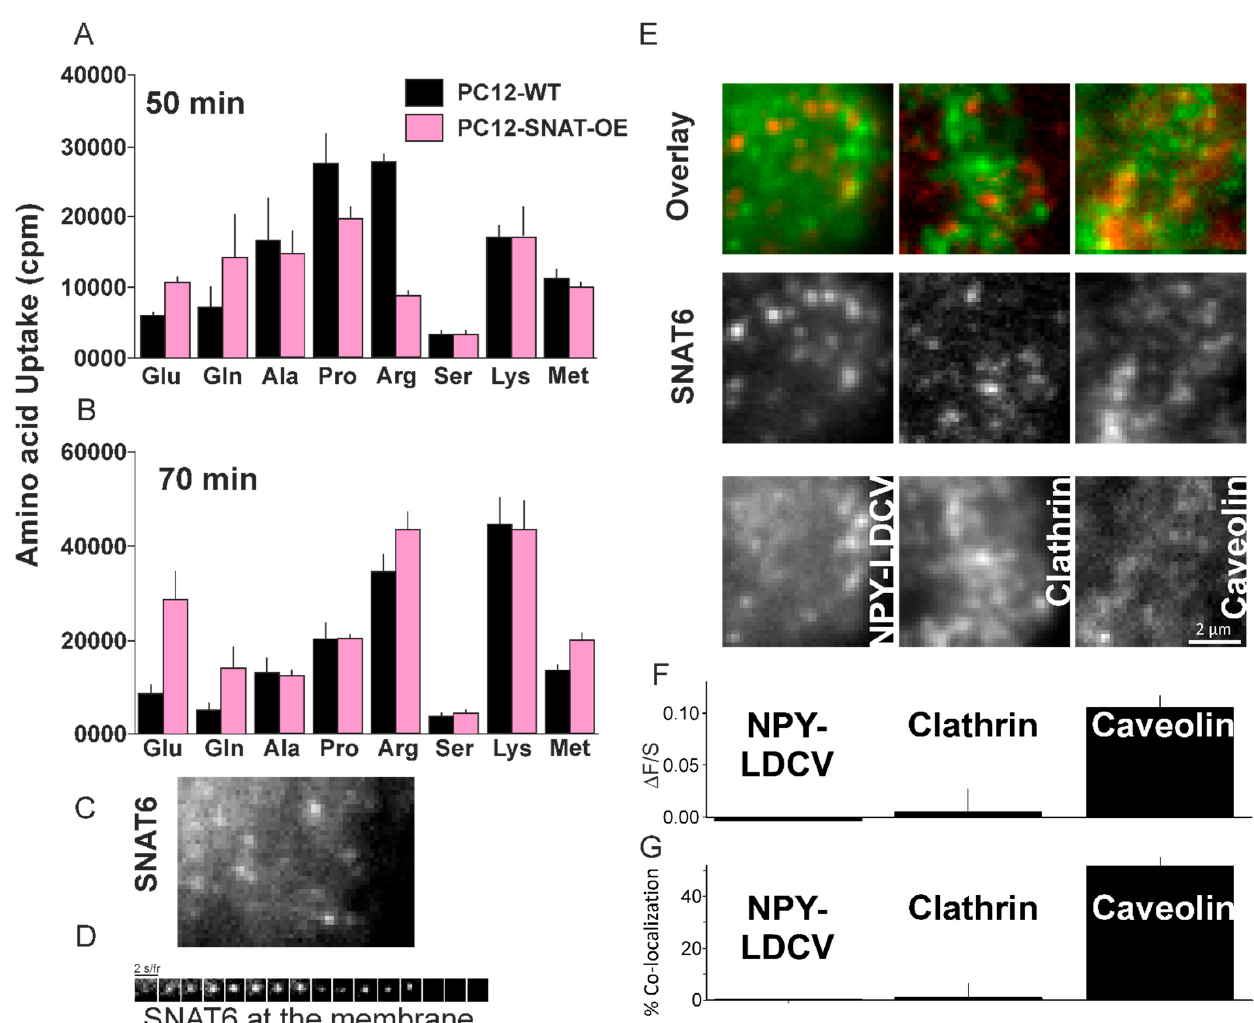
Figure 4. Role of SNAT6 in amino acid uptake and internalization. ( A ) Uptake in counts per minute (cpm) for 50 minutes by wildtype PC12 cells and PC12 cells overexpressing SNAT6 are plotted. ( B ) Uptake in counts per minute (cpm) for 70 minutes by wildtype PC12 cells and PC12 cells overexpressing SNAT6 are plotted. 3H-labeled Glutamine, glutamate, alanine, proline, arginine, serine, lysine and methionine are used for both time points. All measurements were performed in duplicates for multiple times and mean value is shown. Significantly higher uptake ( p < 0.001) is shown for the amino acids - glutamine and glutamate in PC12-SNAT6-OE cells compared to PC12-wt cells after 50 mins. ( C ) A TIRF microscopy image showing cells overexpressing SNAT6-EGFP at the plasma membrane ( D ) Time series strip showing disappearance of SNAT6-EGFP from the plasma membrane in presence of glutamine. ( E ) Images of a cell overexpressing SNAT6-EGFP in red with NPY-mCherry or Clathrin-mCherry or Caveolin-mCherry in green channels respectively with a corresponding image in the overlay. ( F ) Quantification of binding to the SNAT6 site ( Δ F/S) for NPY, clathrin and Caveolin respectively (described in methods). Localization of SNAT with Caveolin was significantly higher compared to NPY or clathrin ( p < 0.001). ( G ) Co-localization from the images similar to E were analyzed (described in methods). SNAT co-localization with caveolin was significantly higher than its co-localization with NPY of clathrin ( p < 0.005). All the TIRF imaging experiments were repeated at least 3 times with at least 8 cells per time.